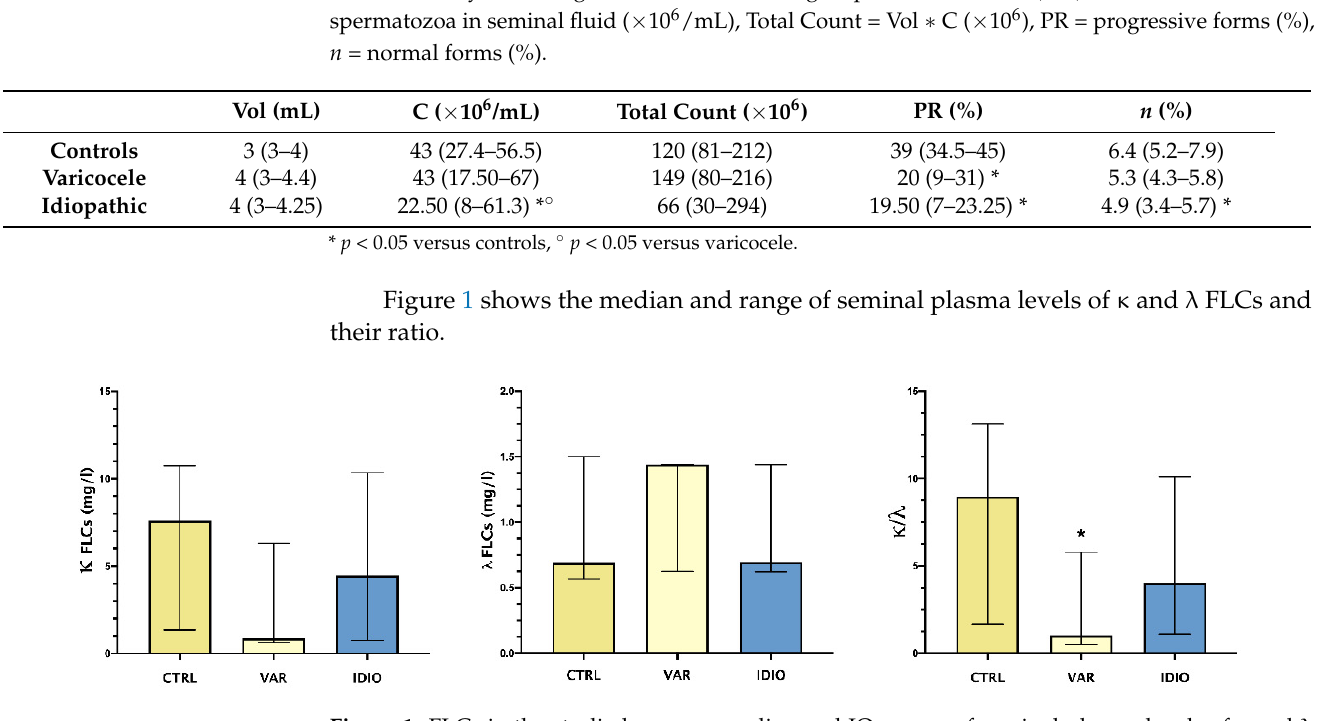
Table 1. Median and interquartile range of the main seminal parameters used for evaluation of male infertility according to WHO in the three groups. Vol = volume (mL), C = concentrations of spermatozoa in seminal fluid (×10 6 /mL), Total Count = Vol * C (×10 6 ), PR = progressive forms (%), n = normal forms (%).